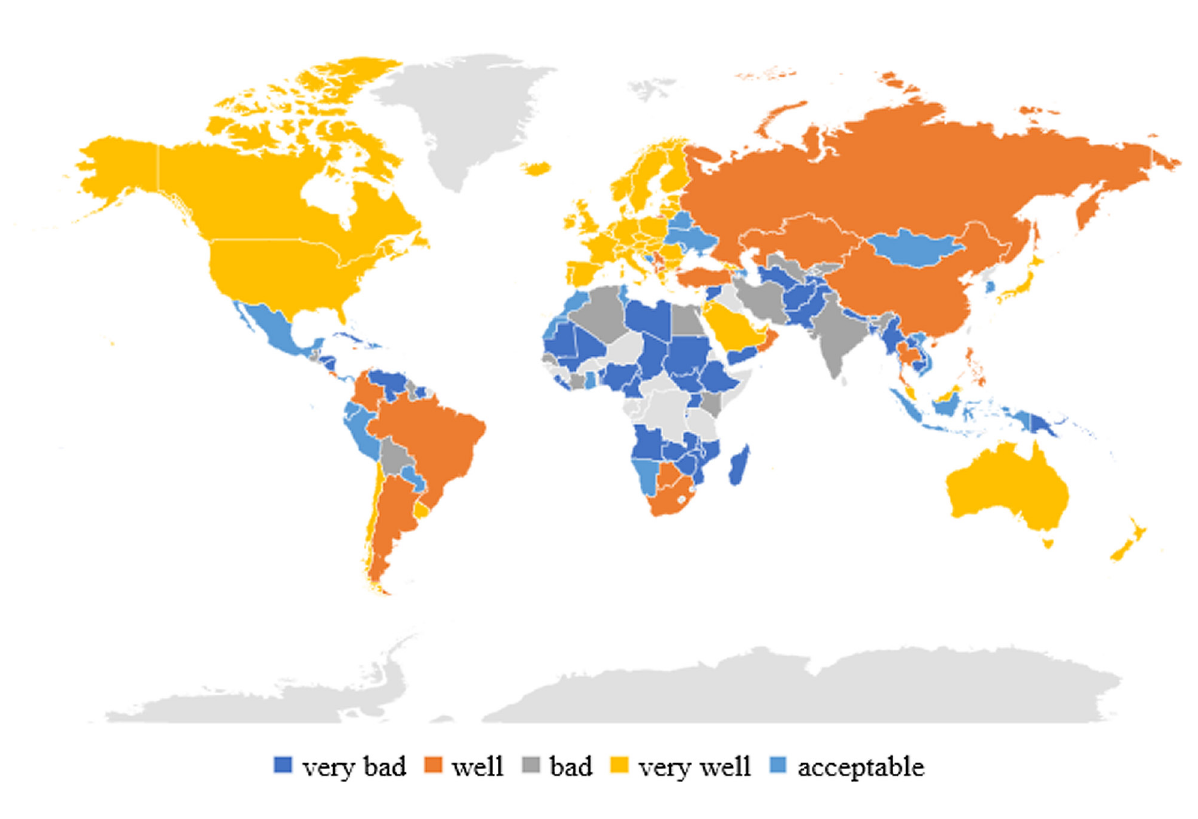
Figure 5. Map of the distribution of countries according to the information security threat